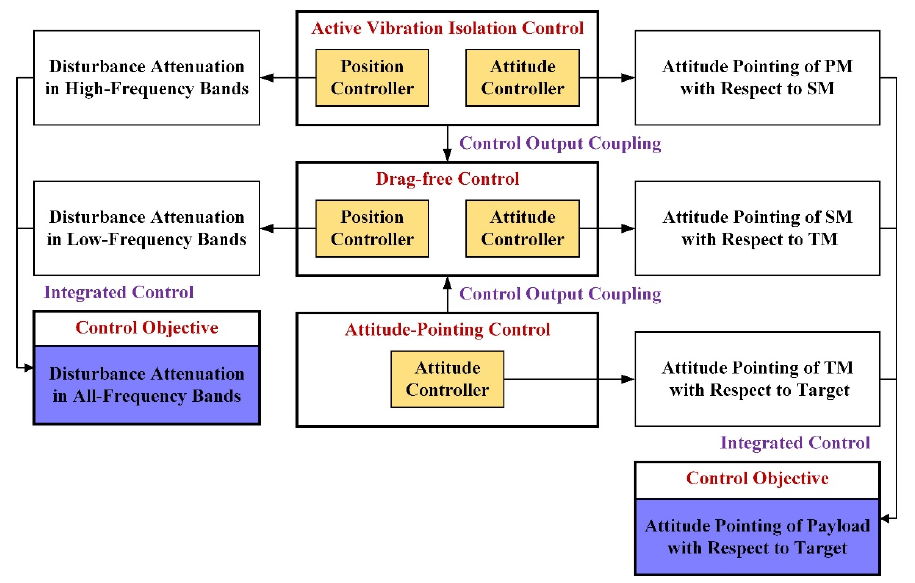
Figure 4. Relationship among the three control loops of the integrated control system. Based on the Proportional–Integral–Derivative (PID) control algorithm, the inte- grated control system for the improved DFP spacecraft is designed as